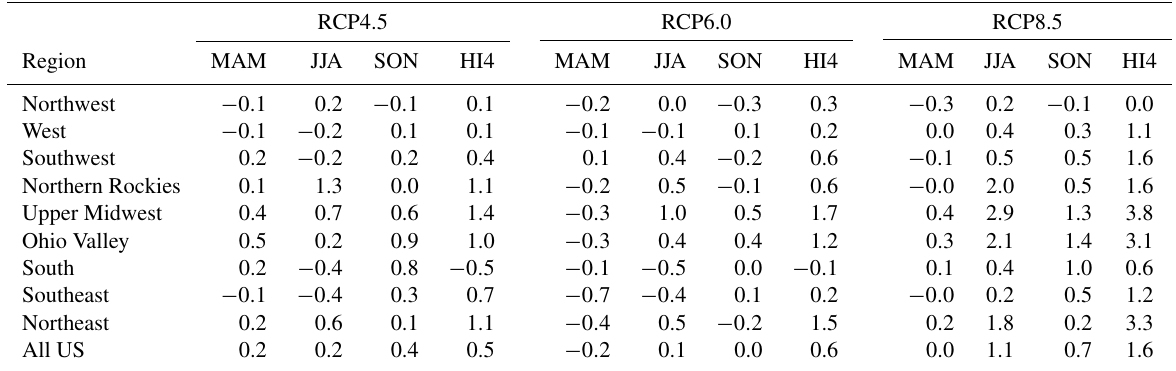
Table 2. Changes in maximum daily 8h O 3 by region.